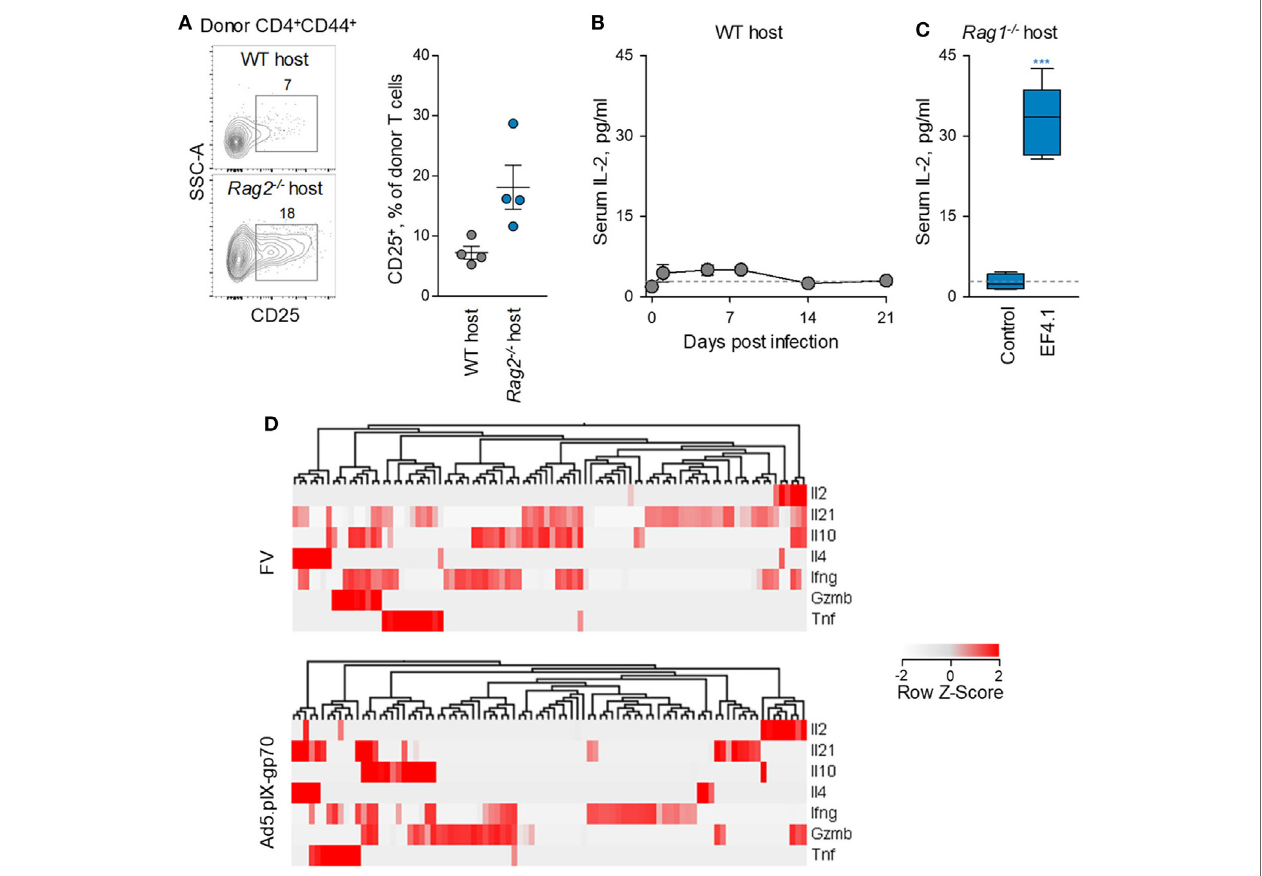
FigUre 7 | Defective IL-2–IL-2R axis in CD4 + T cell response to F-MLV env. (a) Flow cytometric example ( left ) and frequency of CD25 expressing cells ( right ) expression in env-reactive donor CD4 + T cells, 7 days after transfer into Friend virus (FV) infected WT or Rag2 − / − recipients. (B) Mean ( ± SEM) levels of IL-2 in the serum of WT B6. Fv2 s mice at different time-points after intermediate FV infection ( n = 4–5 per time-point). (c) Mean ( ± SEM) levels of IL-2 in the serum of Rag1 − / − mice 35 days after infection with an intermediate dose of FV (control, n = 4) and those additionally received CD4 + EF4.1 T cells at the time of infection (EF4.1, n = 5). (D) Heatmap and hierarchical clustering of cytokine gene expression, assessed by single-cell RNA sequencing, in env-reactive donor CD4 + T cells isolated from the spleens of WT recipients infected with FV or immunized with Ad5.pIX-gp70. Each column represents an individual